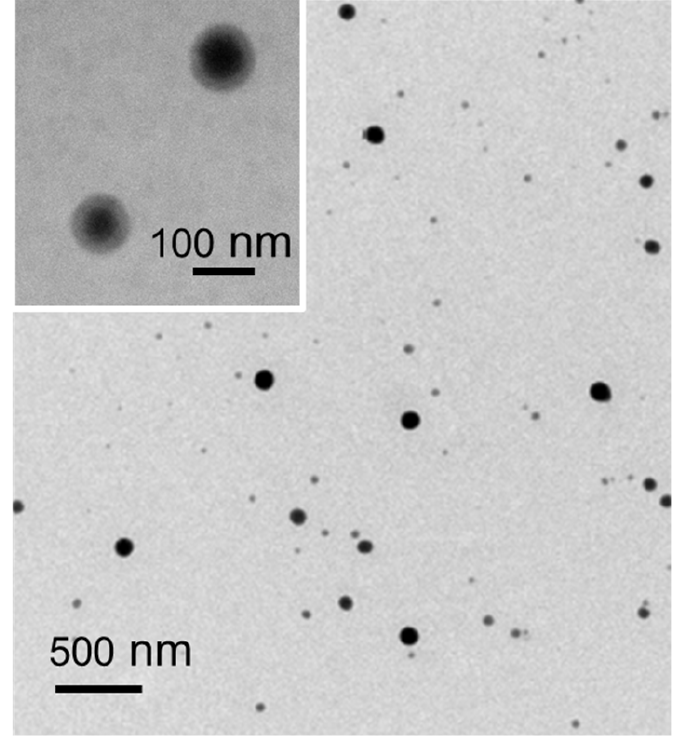
Figure 3. TEM images of the bio-nanocomposite suspensions prepared with SeNPs stabilized by A. macleodii Mo169 EPS.